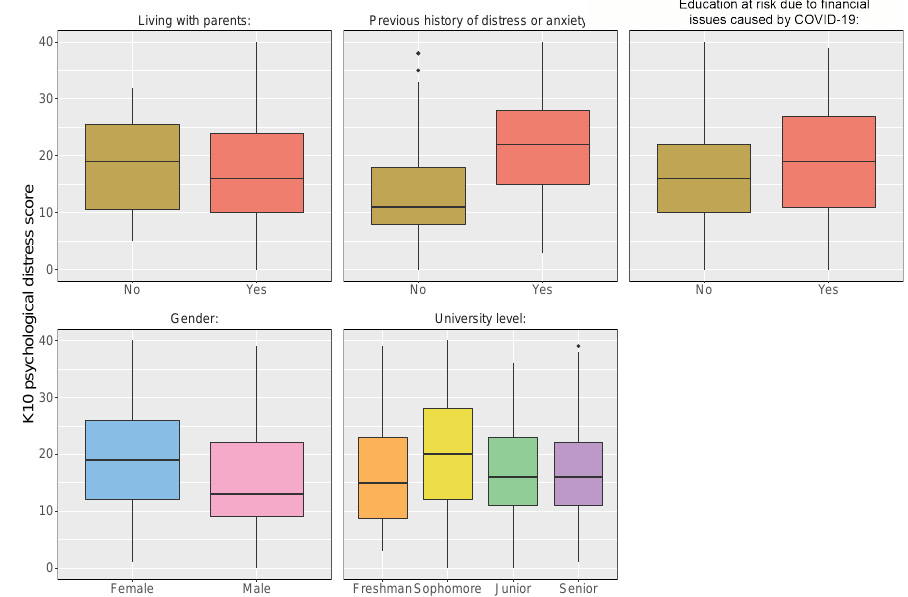
Figure 4. Psychological distress of demographic